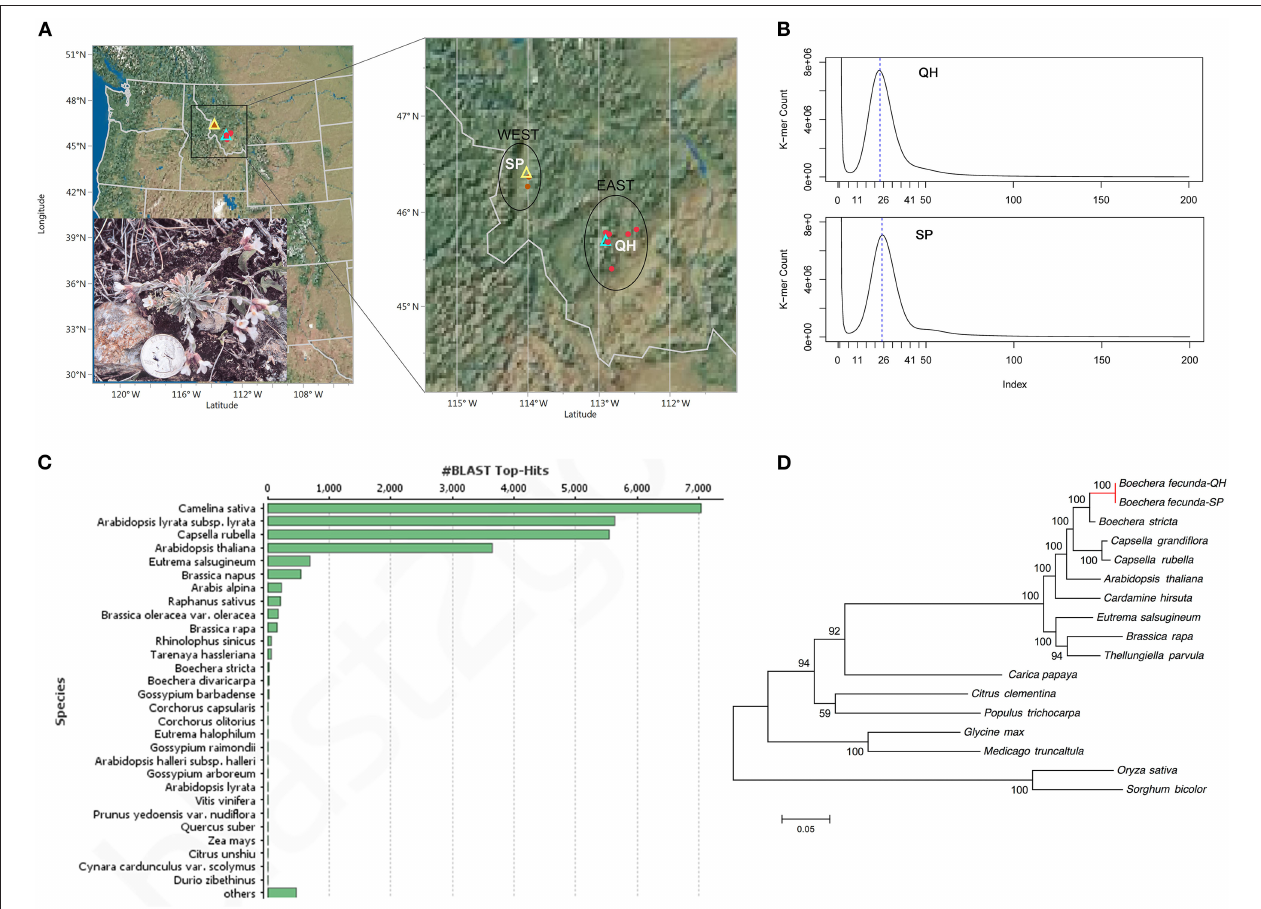
FIGURE 1 | (A) Geographic location of two ecotypes of B. fecunda . The left panel shows locations of the populations in Montana, United States. The zoomed-in region is illustrated in the right panel. Red solid dots represent all 29 accessions of B. fecunda described in McKay et al. (2001) and Song and Mitchell-Olds (2007), of which QH and SP were highlighted with cyan and yellow hollow triangles, respectively. This figure was prepared with JMP pro 13.0.0 (SAS Institute Inc., Cary, NC, United States). The imbedded photo shows a Quarter-size B. fecunda plant at the stage of flowering in the wild. ( B) Distribution of 17-mer frequency for QH and SP sequencing reads. (C) A list of species to which most sequence was aligned. (D). Phylogenetic tree across 14 plant species including the SP and QH ecotypes of B. fecunda . The numbers above the branches indicate the bootstrap